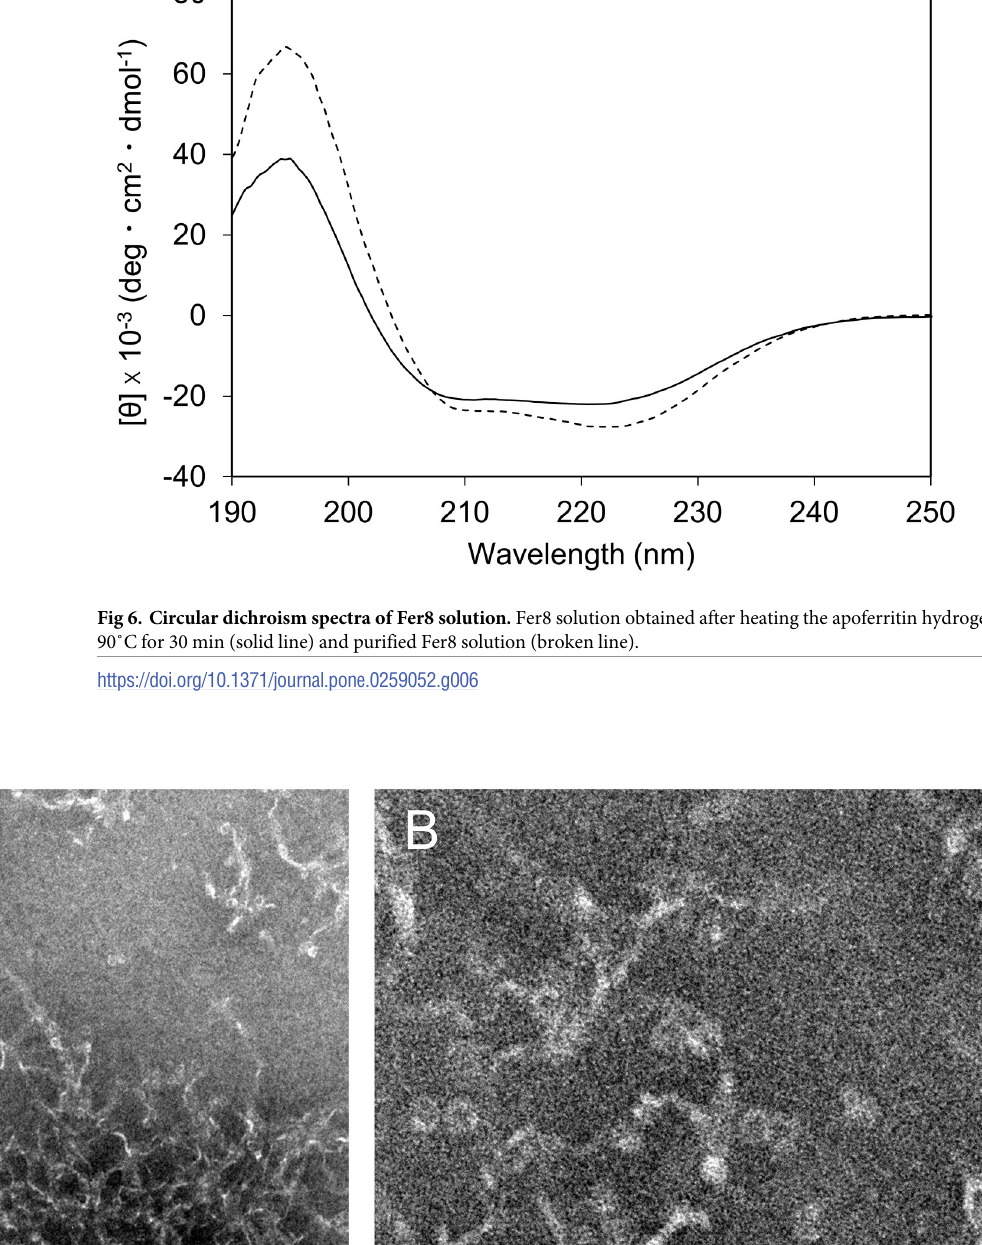
PLOS ONE | https://doi.org/10.1371/journal.pone.0259052 November3,